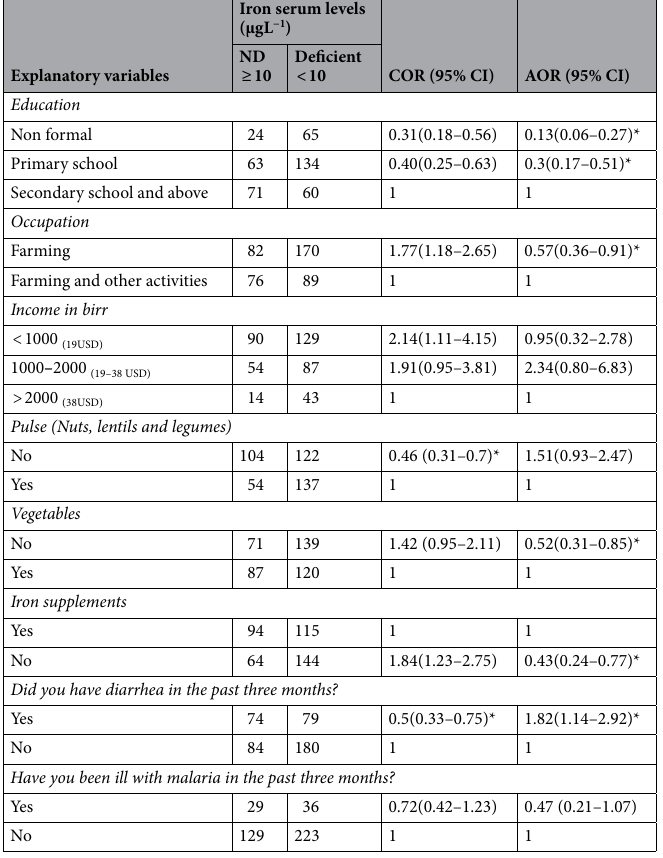
Table 3. Results of logistic regression model for risk factors associated with iron deficiency of pregnant women small-scale farmers in Kellem Wellega zone, western Ethiopia, 2021. AOR adjusted odds ratio, COR crude odds ratio, CI confidence interval, Other activities: (daily labourer, private business, non-Government and civil servants), ND non deficient; and *represent the level of significance at p values less than